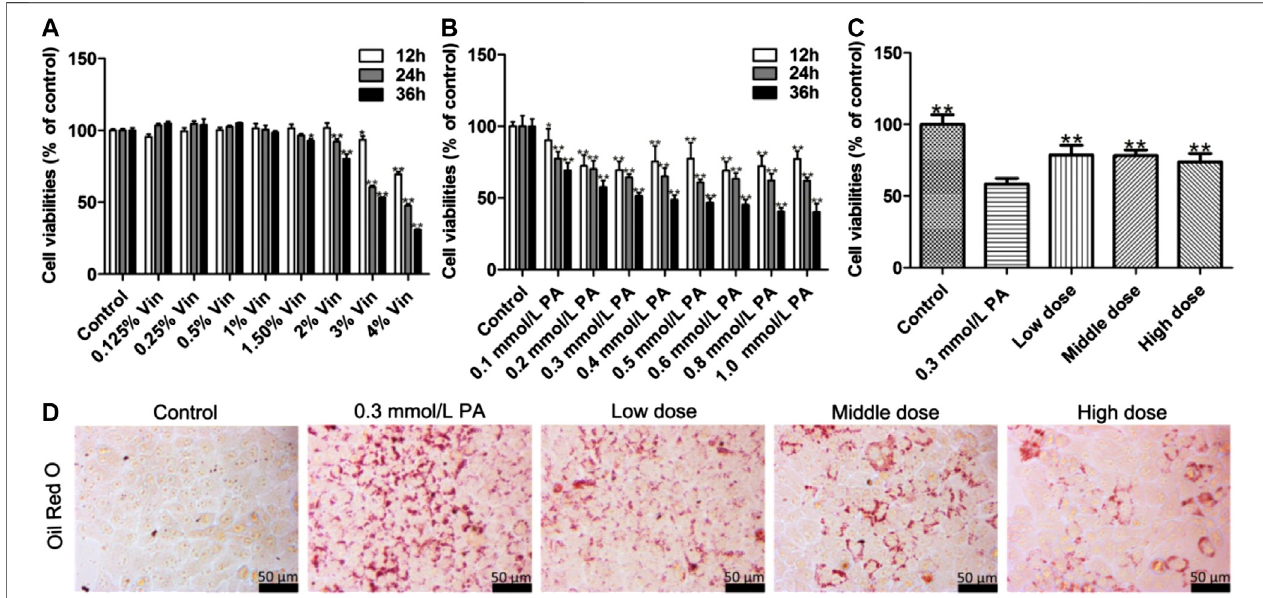
FIGURE 1 | Protective effects of aromatic vinegar on palmitic acid (PA)-induced damage in HepG2 cells. (A) Cytotoxicity of aromatic vinegar (Vin) on HepG2 cells; (B) Effects of PA on cell viability; (C) Effects of aromatic vinegar attenuated on PA-induced cell damage; (D) Effects of aromatic vinegar on Oil Red O staining in HepG2 cells ( × 400 magni fi cation; Scale bar (cid:2) 50 µm). Values are expressed as the mean ± SD (n (cid:2) 5). * p < 0.05, ** p < 0.01 compared with model groups.